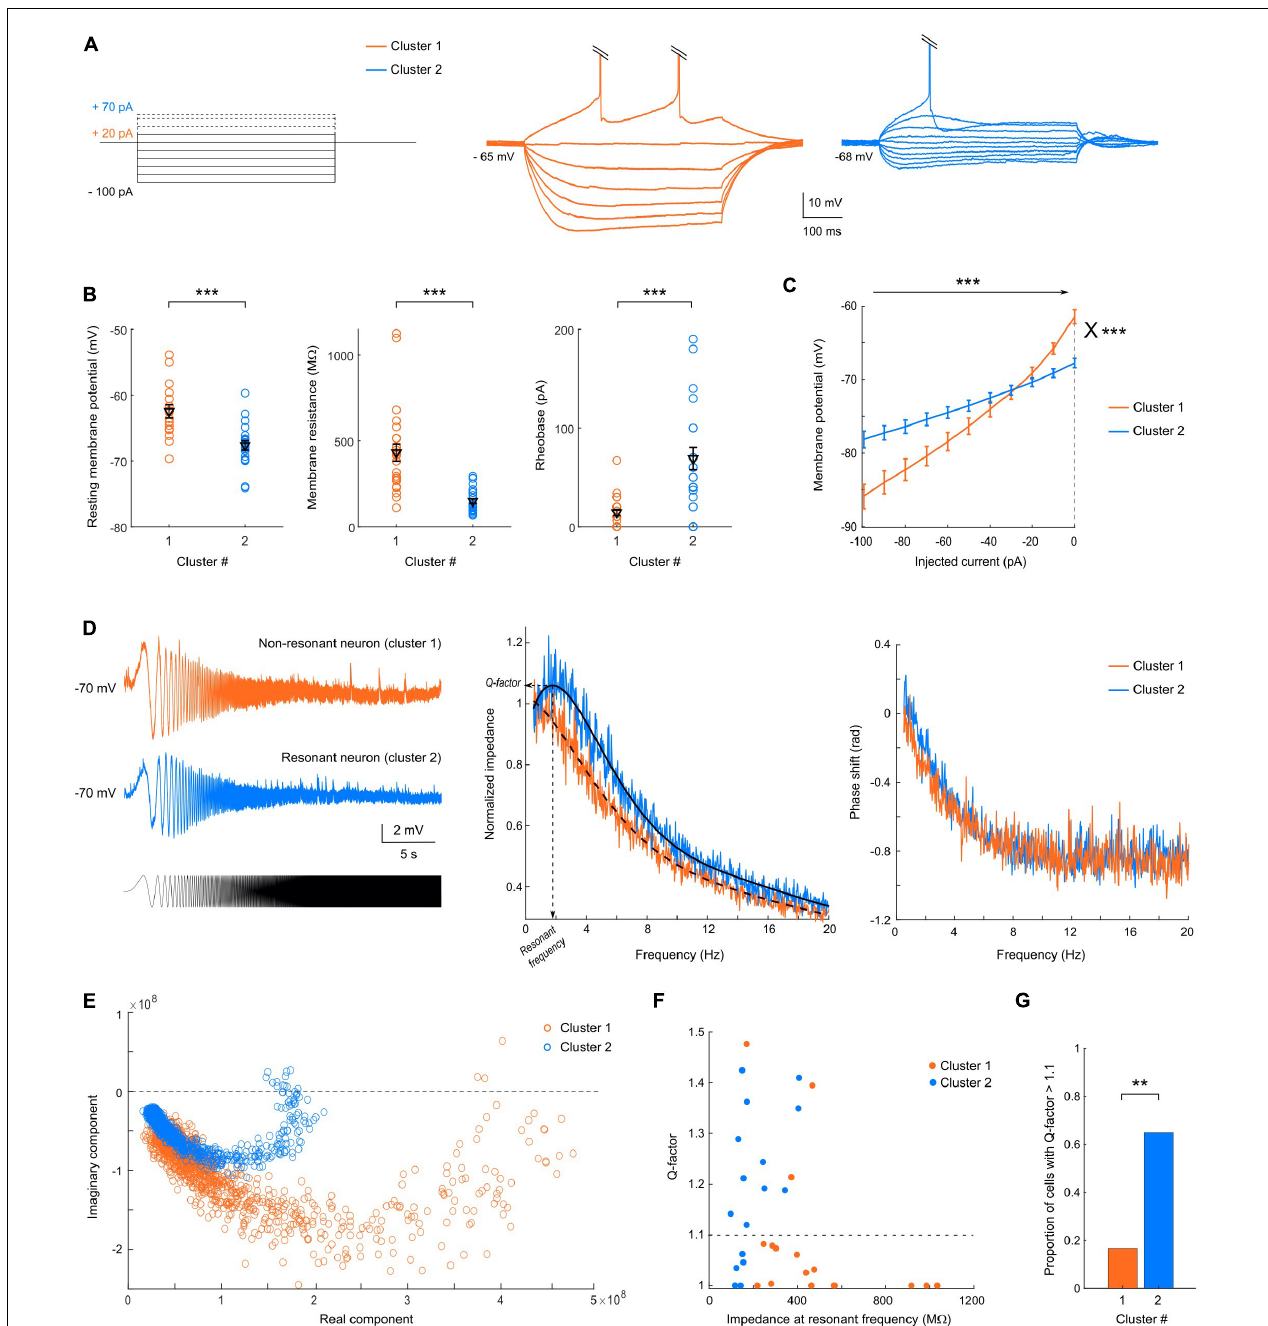
FIGURE 2 | The two clusters exhibit different passive membrane properties. (A) Representative responses of cluster 1 (orange, center) or cluster 2 (blue, right) neuron to current step injections (left), from –100 pA to rheobase. (B) Scatter plots of the passive membrane properties showing significant differences between the two clusters, with mean and SEM indicated in black. Cluster 1 neurons, indicated in orange, have a more depolarized resting membrane potential ( p < 0.001), a higher membrane resistance ( p < 0.0001) and a lower rheobase ( p < 0.0001) than cluster 2 neurons, shown in blue. (C) Average IV-curves show an inward rectification for cluster 1, but a linear relationship between the injected current and membrane potential for cluster 2, and highlight the differences in membrane resistance and resting membrane potential. (D) (left) Example of voltage responses to a sinusoidal chirp current injection (bottom) for a representative non-resonant neuron belonging to cluster 1 and a resonant neuron from cluster 2. (Center) Average resonant impedance profiles for the two clusters (black: smoothing average); the resonant frequency and Q-factor are indicated for cluster 2. (right) Phase shift of the voltage waves relative to the injected current as a function of frequency. (E) Impedance vectors in the complex plane. The distance to the origin corresponds to the impedance magnitude and the angle with the real axis corresponds to the phase shift. Frequency increases in the clockwise direction. (F) Distribution of Q-factors as a function of the impedance amplitude at the resonant frequency and of the clustering classification. (G) Proportion of resonant cells (Q factors > 1.1), in cluster 1 and 2 (Chi-square test = 8.41; p = 0.0037). All data: mean ± SEM. * p < 0.05; ** p < 0.01; *** p < 0.001.